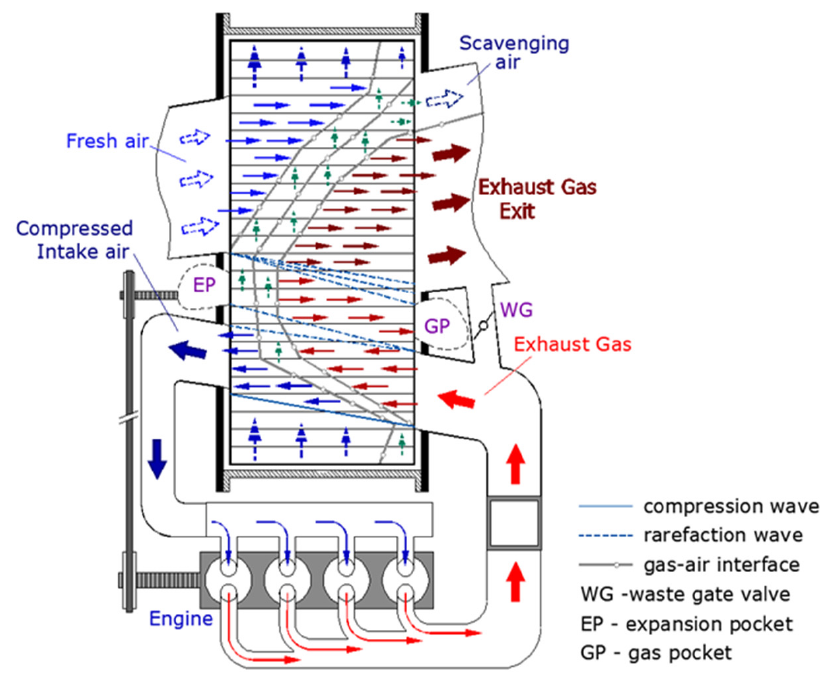
Figure 3. Fluid motion inside the PWS. Reprinted/adapted with permission from Ref. [12]. 2020, The Romanian Journal of Technical Sciences. Applied Mechanics.